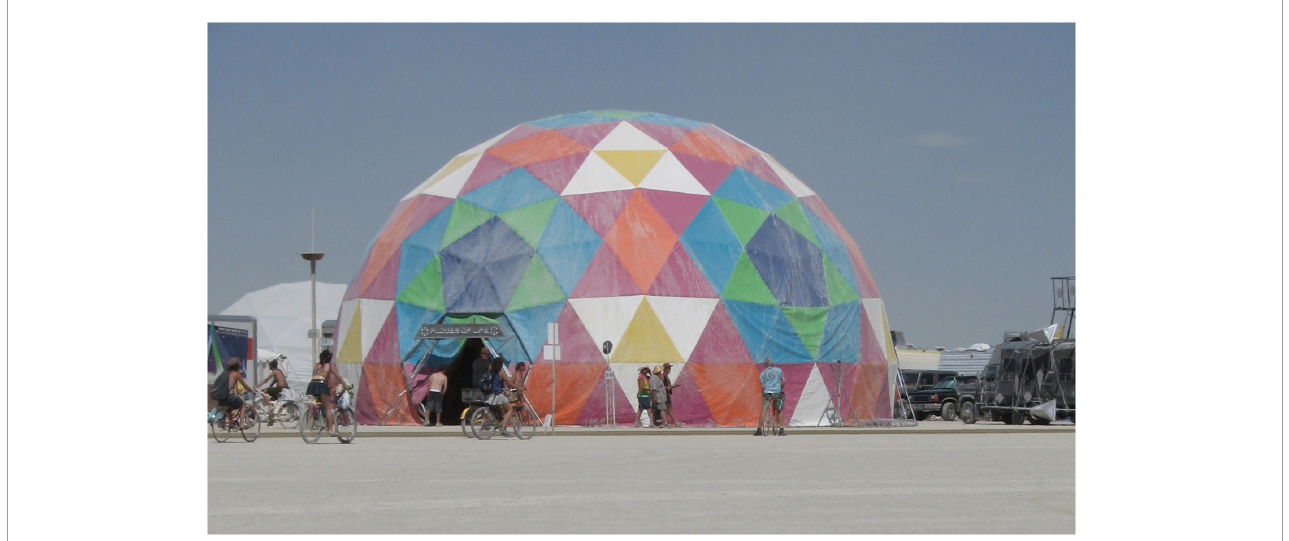
FIGURE1 A geodesic model of the bio-tensegrity structure. Each sheet may represent an area of fascia in the system. Each “sheet” has its spring constant set by fascial qualities and myofibroblast generated forces. Mechanical forces can travel to other areas through connections in the structure and myofascial chains. With permission from PACIFIC DOMES Inc. www.eventdome.wordpress.com. Reprinted from https://eventdome.files.wordpress.com/2010/07/bm-multi-colored.jpg, with permission from Sequoia Miller from Pacific Domes Inc.